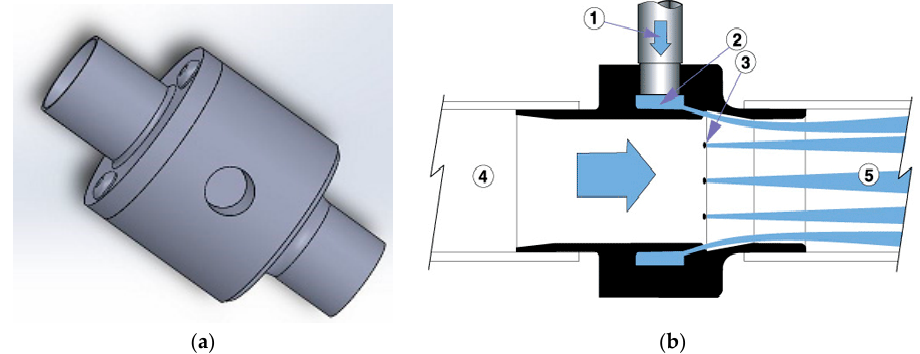
Figure 2. ( a ) 3D image of Exair in-line Vacuum; ( b ) Cross sectional view of in-line vacuum, Compressed air flows through the inlet (1) in to an annular plenum chamber (2) it is then injected through directed nozzles (3), the jets of air create a vacuum at the intake (4) which draws the fibers and accelerate them through the unit (5) at the same time the air pressure and flow breaks fiber clumps and disperse them in the air at (5). Image courtesy of Exair Corporation